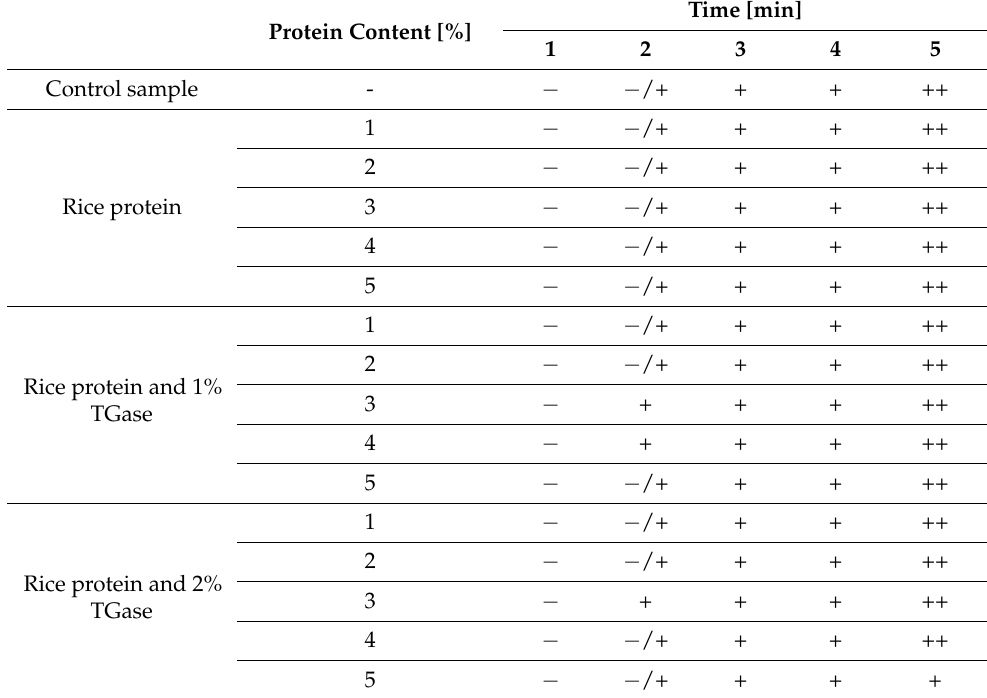
Table 1. Hydration times of instant noodles with the addition of rice protein, rice protein and TGase (the meaning of symbols used for evaluation is as follows: “ − ”-hard instant noodle, “ − /+”-semi-soft instant noodle, “+”-soft instant noodle, “++”-very soft instant noodle). Time [min] Protein Content [%] 1 2 3 4 5 Control sample - − − /+ + + ++ 1 − − /+ Rice protein